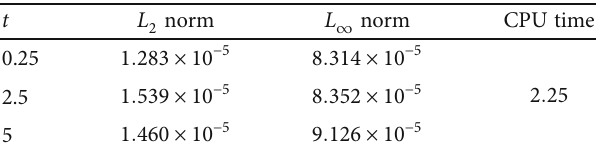
Table 4: L 2 and L ∞